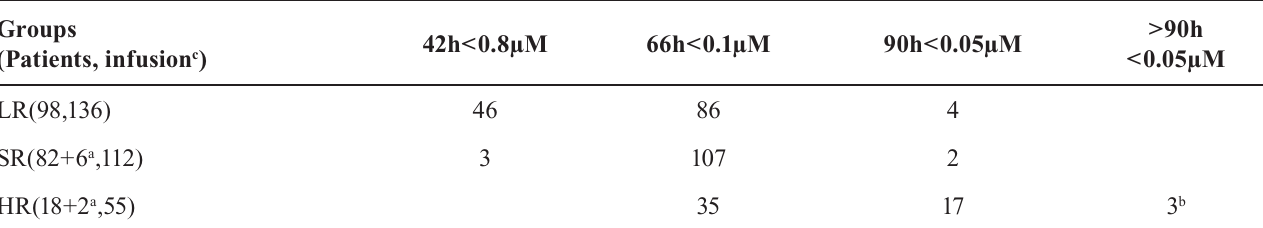
TABLE I - T he Risk groups and methotrexate levels at different time points